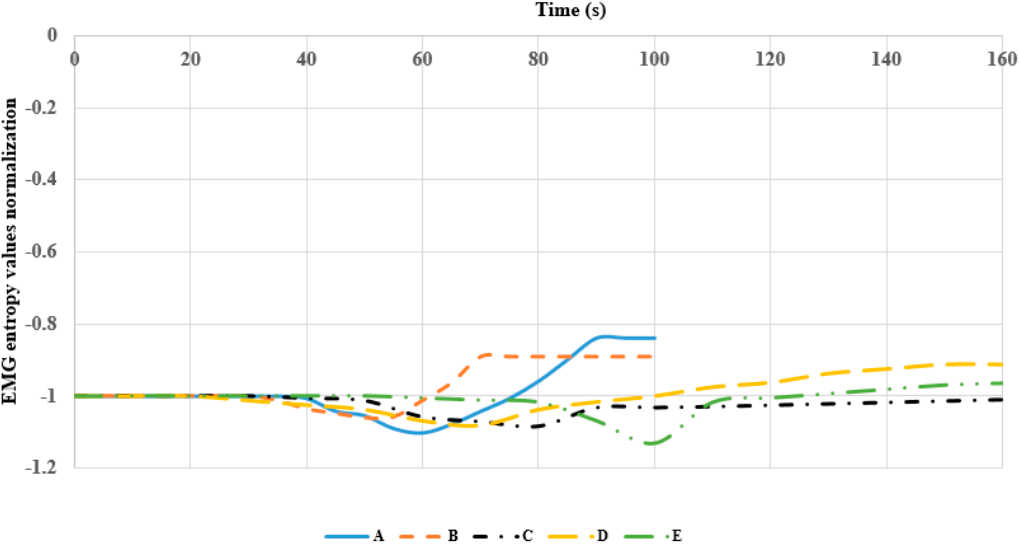
Figure 16. Comparison of entropy values of subjects under 11 kg load.